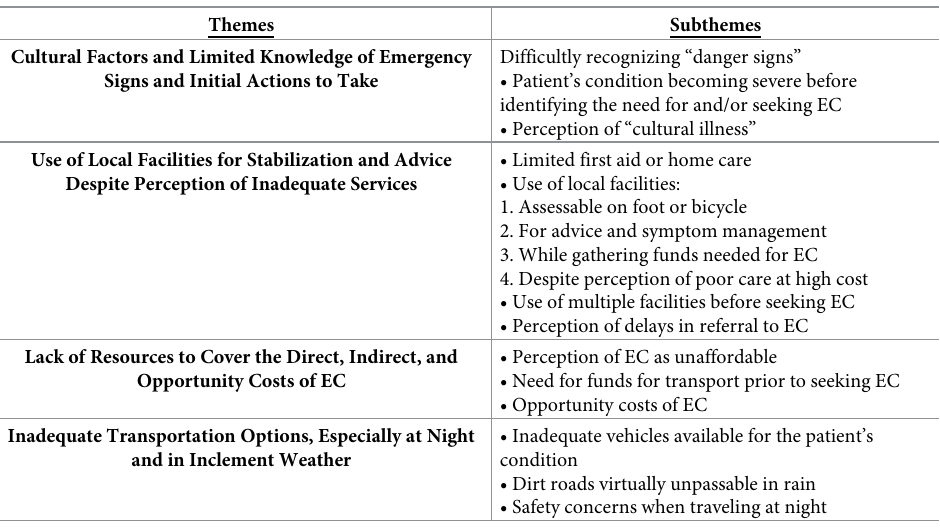
Table 4. Themes and subthemes in delay